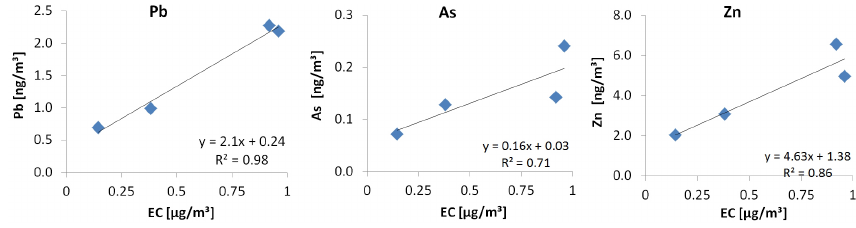
Figure 4. PM 3 . 5 scatter plots of Pb, As, Zn against EC at the upwind stations.